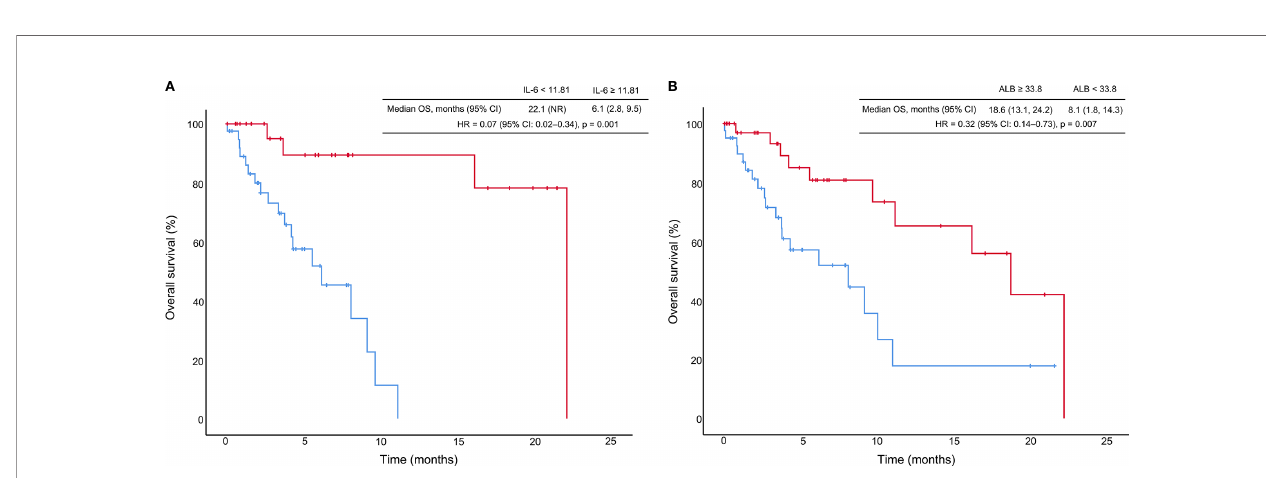
FIGURE 4 | Kaplan – Meier curves of overall survival (OS) strati fi ed by interleukin-6 (IL-6) levels (A) and albumin (ALB) concentration (B) . HR, hazard ratio; CI, con fi dence interval; the unit for IL-6 is pg/ml; the unit for ALB is g/L.